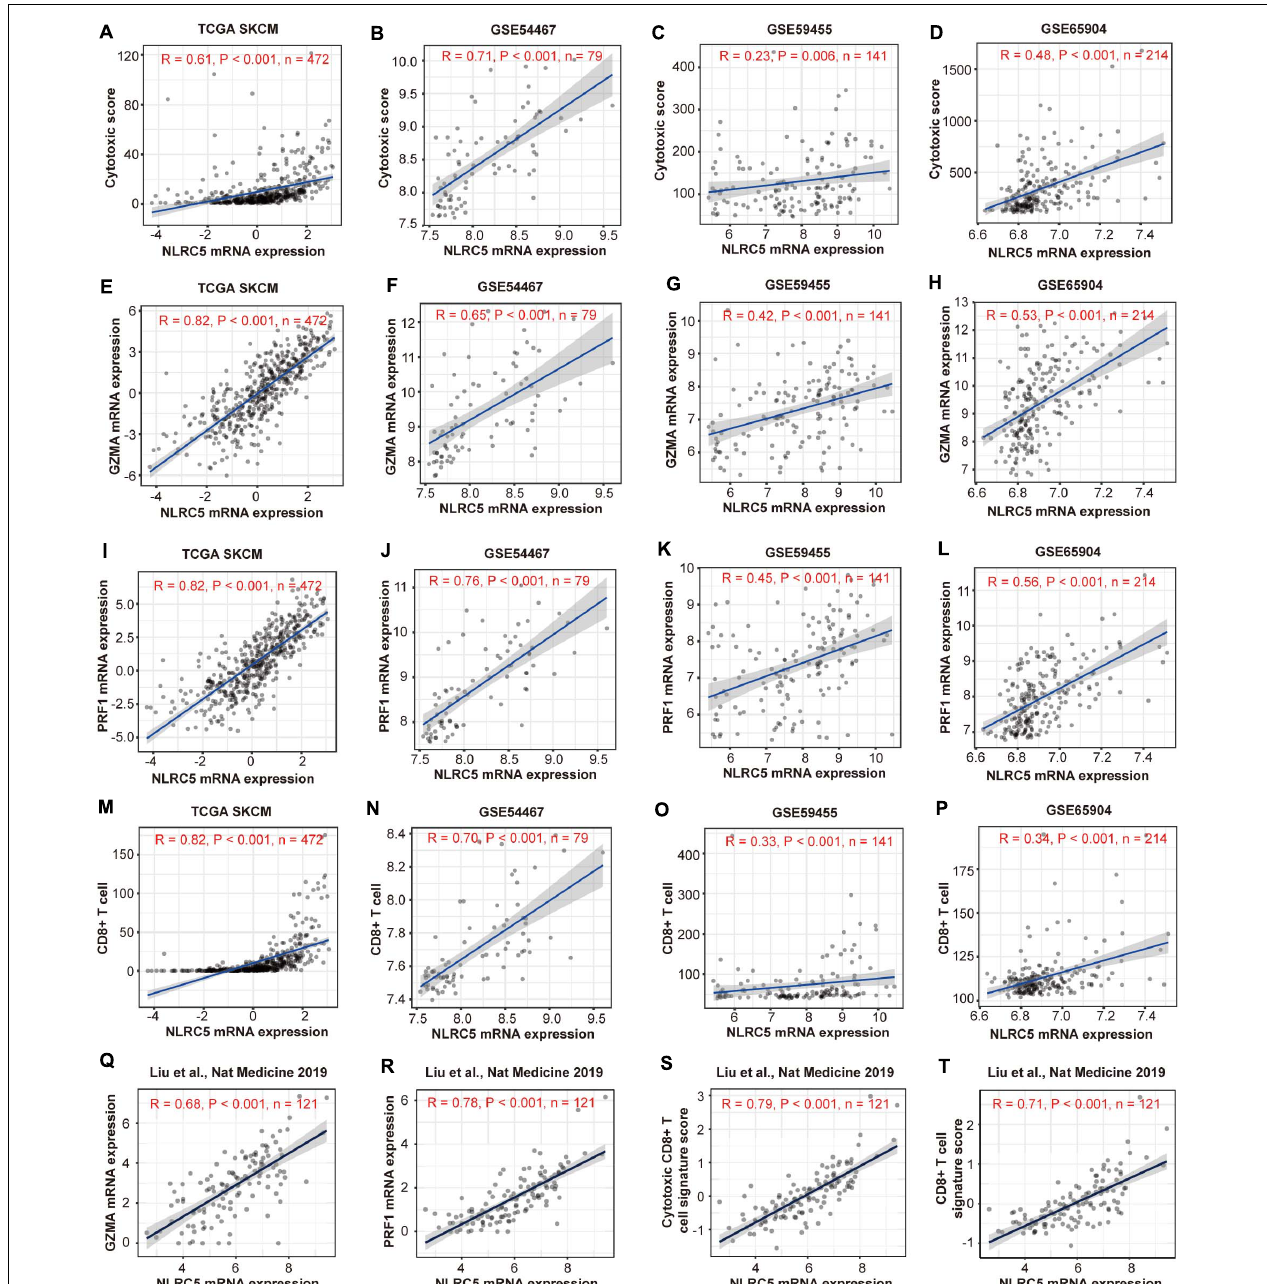
FIGURE 7 | Expressions of NLRC5 correlates positively with cytotoxic signature in melanoma datasets. (A–D) Spearman correlation analysis of the NLRC5 expression and cytotoxic score in TCGA SKCM, GSE54467, GSE59455, and GSE65904, respectively. (E–H) Spearman correlation analysis of the NLRC5 and GZMA expression in TCGA SKCM, GSE54467, GSE59455, and GSE65904, respectively. (I–L) Spearman correlation analysis of the NLRC5 expression and PRF1 expression in TCGA SKCM, GSE54467, GSE59455, and GSE65904, respectively. (M–P) Spearman correlation analysis of the NLRC5 expression and infiltrating level of CD8 + T cells in TCGA SKCM, GSE54467, GSE59455, and GSE65904, respectively. (Q–T) Spearman correlation analysis of the NLRC5 expression and GZMA expression, PRF1 expression, cytotoxic CD8+ T cell signature score, CD8+ T cell signature score in “Liu et al., Nat Medicine 2019,” respectively. Spearman r and p -value for each correlation are